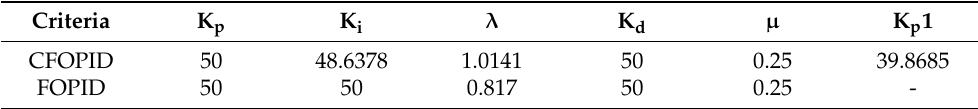
Table 4. The optimal values of the controllers.